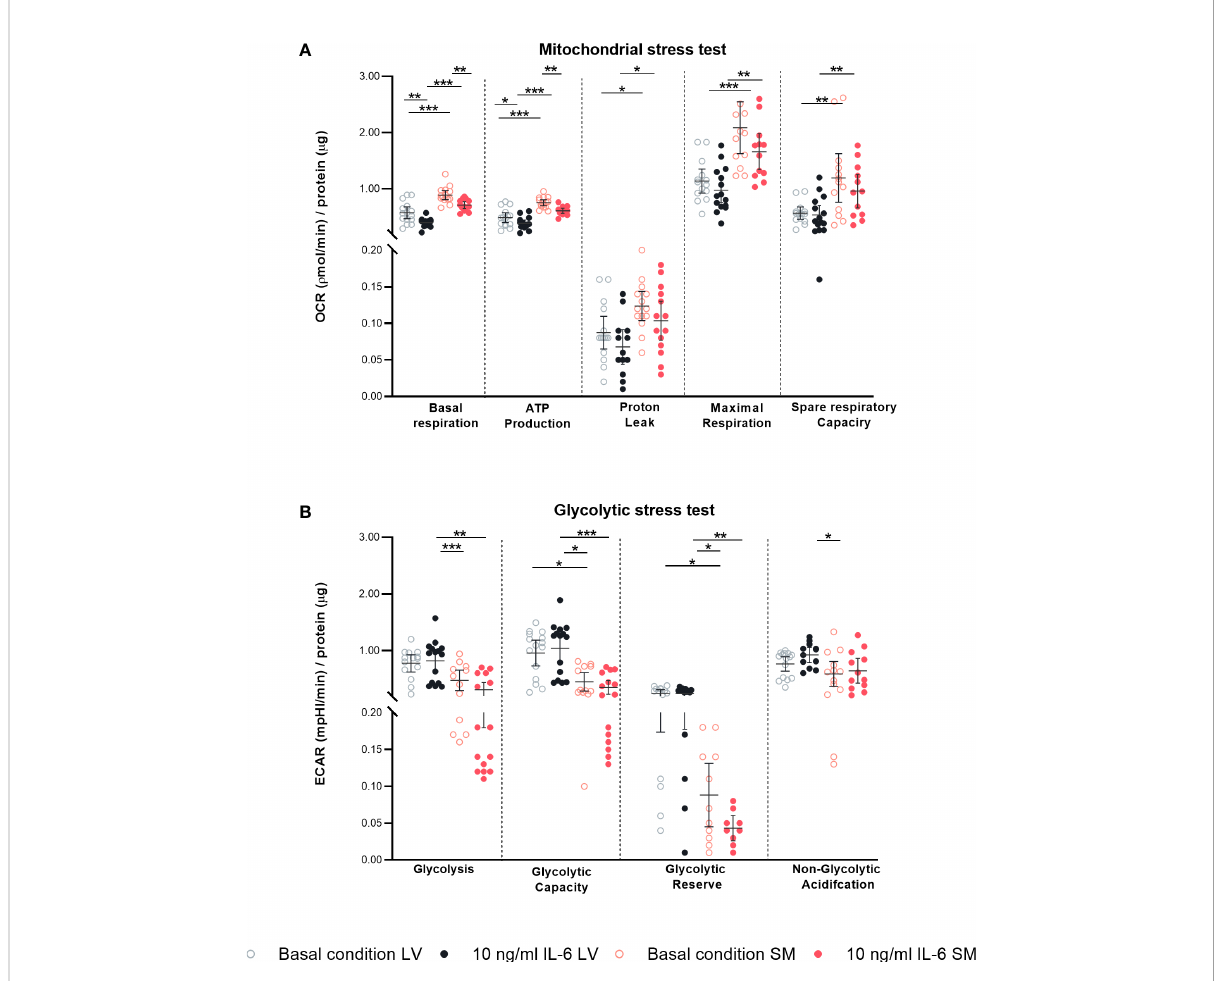
FIGURE 6 IL-6 stimulation leads to differential regulated mitochondrial and glycolytic disturbances in left ventricle (LV)- versus skeletal muscle (SM)- derived fi broblasts. Mitochondrial stress test measuring (A) oxygen consumption rate (OCR) describing basal respiration, ATP production, proton leak, maximal respiration, and spare respiratory and glycolytic stress test assessing (B) extracellular acidi fi cation rate (ECAR) describing glycolysis, glycolytic capacity, glycolytic reserve, and non-glycolytic acidi fi cation normalized to protein amount in m g of LV-derived (black) and SM-derived (red) fi broblasts after 4-h culture with basal medium without IL-6 (basal condition; bright hollow circle) or with 10 ng/ml of IL-6 (dark fi lled circle); n = 15, N = 3. All data are presented as mean ± 95% CI and tested with post-hoc Benjamini – Hochberg correction; adjusted p-values: * p < 0.05, ** p < 0.01, *** p <